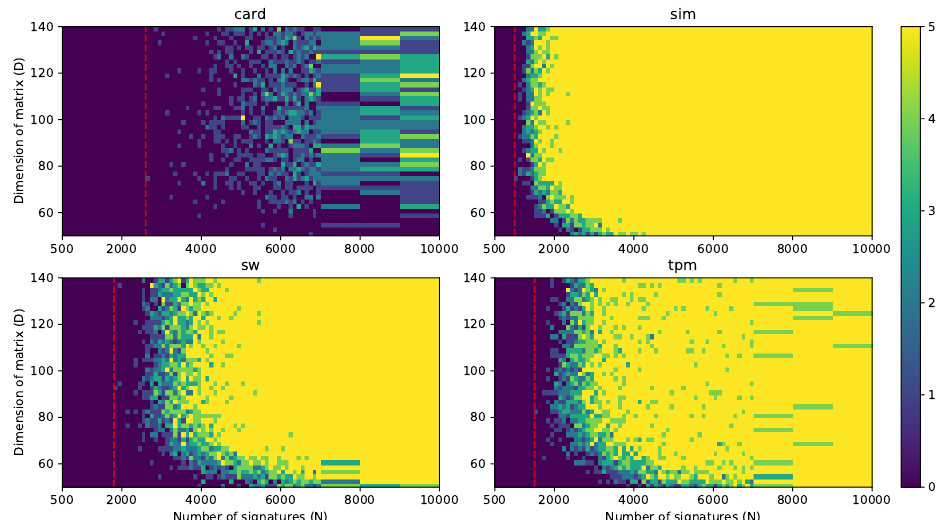
Figure 5: Heatmap of success rate (out of 5 tries) for geometric